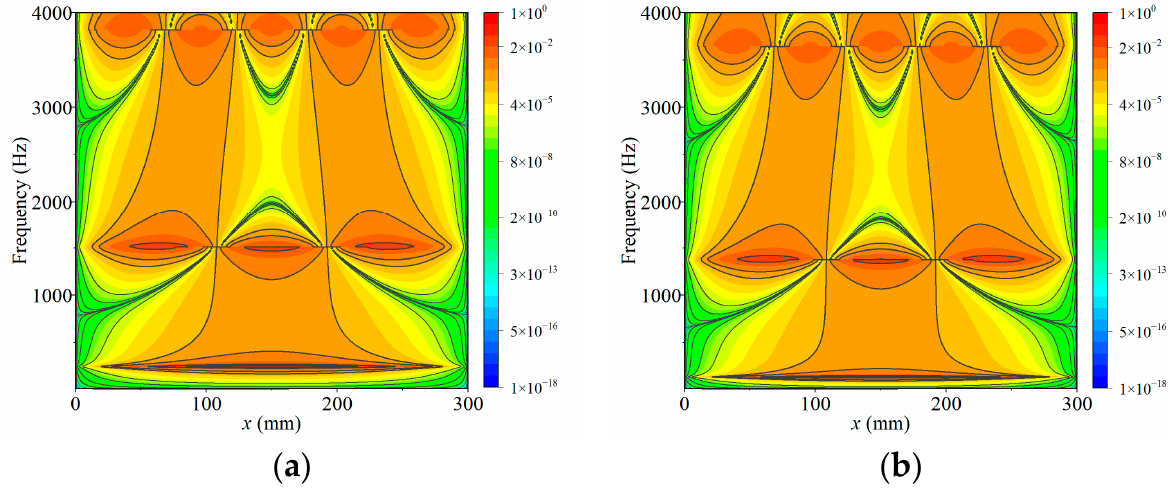
Figure 8. PSD contour of acceleration in the z-direction under different thermal loads (g 2 /Hz): ( a ) case b 1; ( b ) case b 2.